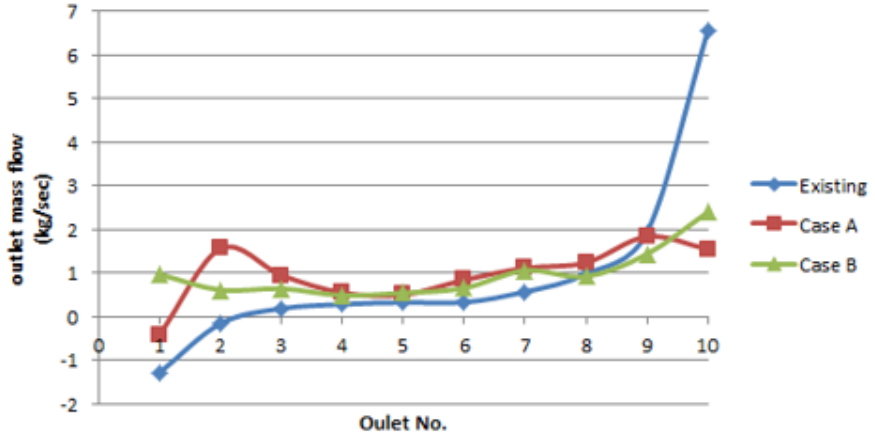
Figure 8. Comparison of CFD simulation results for all three cases.